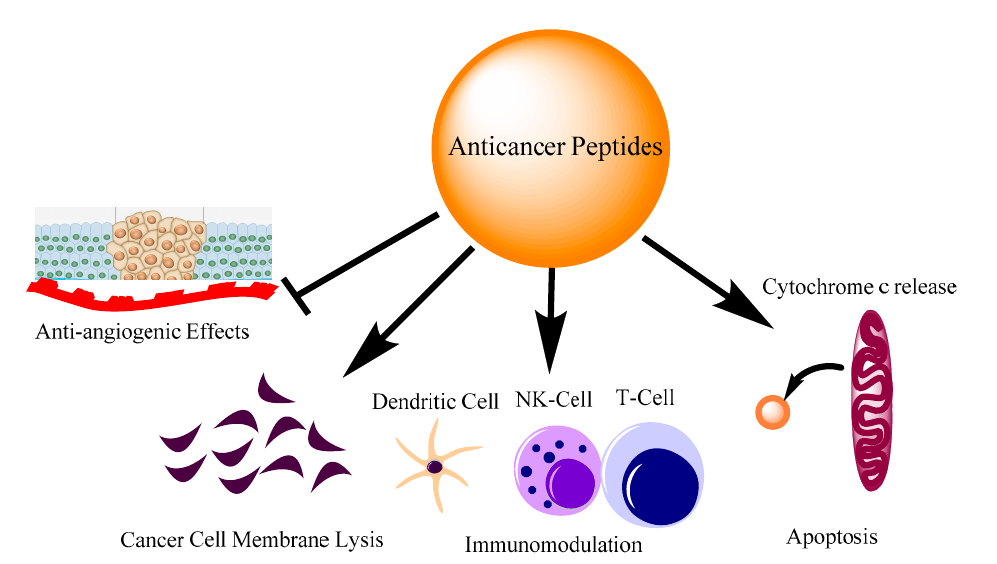
Figure 1. Different modes of action of anti-cancer peptides. The action of peptides involves inhibiting angiogenesis, direct cell membrane lysis, immune cell regulation and apoptosis by cytochrome c release from mitochondria.